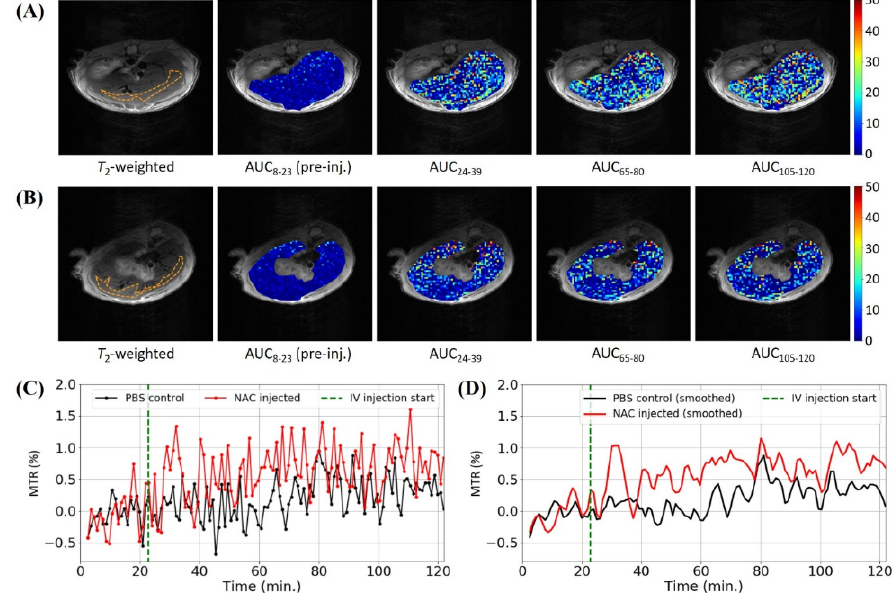
Figure 2. Dynamic CEST data of the representative test (i.e., NAC-injected) ( A ) and control (i.e., PBS-injected) ( B ) mice obtained through saturating at − 2.7 ppm using the CEST-UTE pulse sequence. ( A ) The T 2 -weighted transverse slice of the mouse which was injected (IV) with NAC with its liver overlaid with multiple AUC maps. ( B ) The T 2 -weighted transverse slice of the mouse which was injected (IV) with PBS (control) with its liver overlaid with multiple AUC maps. The orange, dashed outline in first T 2 -weighted images in ( A , B ) represent the ROIs selected for plotting the dynamic MTR curves ( C ). ( D ) The smoothed version of the dynamic MTR curves in ( C ) using the Savitzky–Golay filter. The green dashed line in ( C ) represents the start of the IV